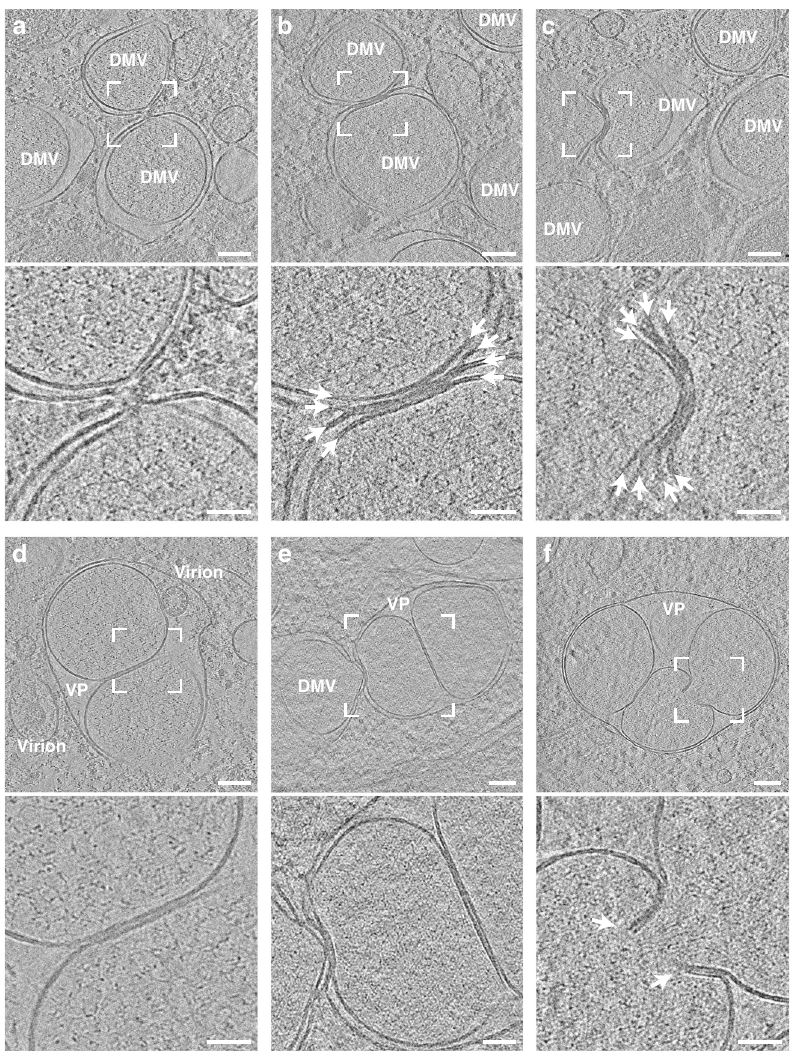
Fig. 2 Juxtaposed DMVs form membrane junctions that lead to homotypic fusion. Tomograms showing DMVs in VeroE6 ( a – c ) and Calu3 ( d – f ) cells at 16 hpi. For each tomogram, a magni fi ed area is shown below and indicated as a white square. 10 slices of the tomogram were averaged. a DMV – DMV interaction via a constricted outer membrane connection. b , c Tightly apposed membrane stack composed of four membranes (arrows) of varying curvature between two juxtaposed DMVs. d VP containing two inner vesicles with a tight membrane – membrane contact. e DMV interaction with a VP containing two inner vesicles. f VPs containing four inner vesicles with tight contact and an opening aperture formed by two stacked membranes indicated by white arrows. Scale bars: a – f 100 nm; magni fi ed areas, 50